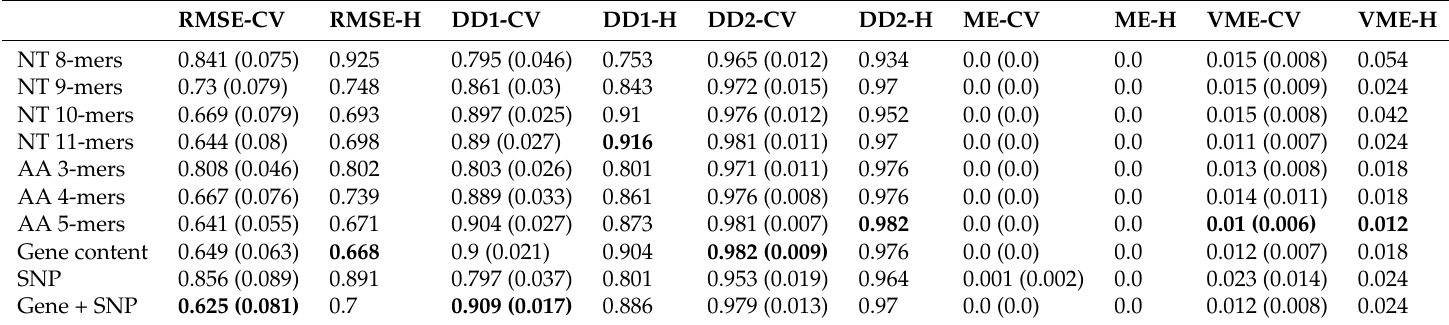
Table A34. K. pneumoniae